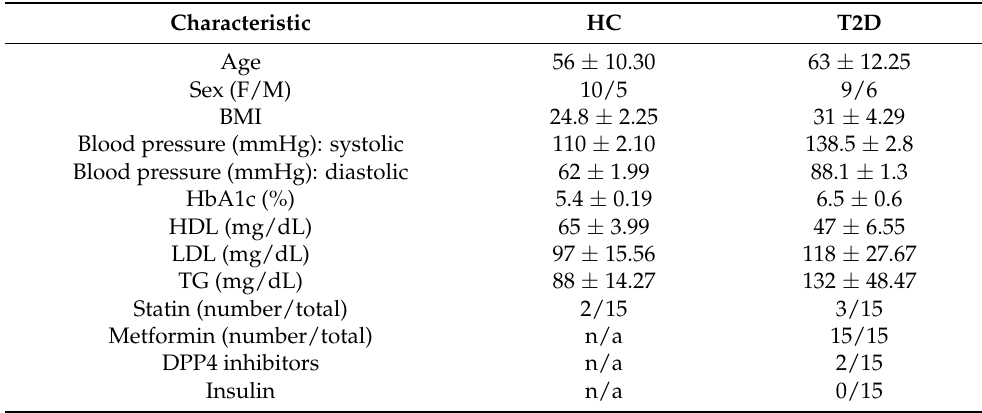
Table 1. Patient characteristics: age, sex (female/male), body mass index (BMI), blood pressure (millimeters of mercury—mmHg), glycated hemoglobin (HbA1c), high-density lipoprotein (HDL), low-density lipoprotein (LDL), tryglycerides (TG), and medication used—statin, metformin, Dipep- tidyl peptidase-4 (DPP4) inhibitors and